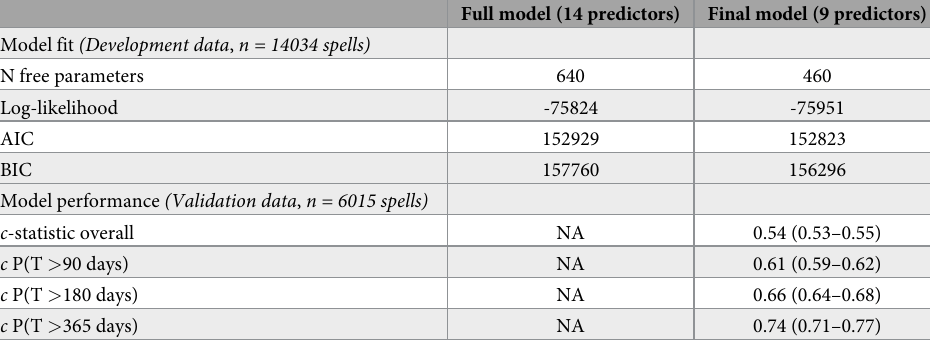
Table 3. Model fit and model performance.